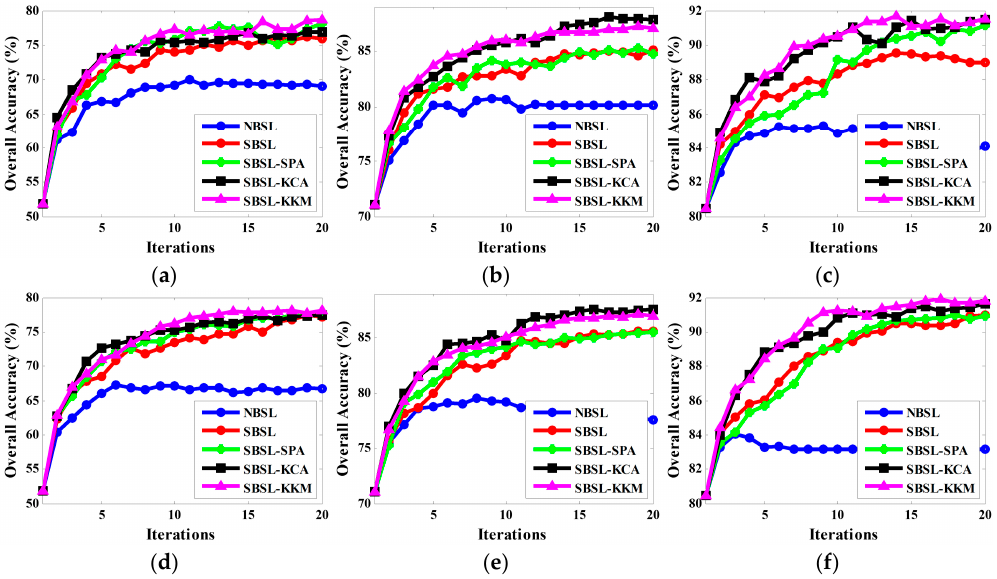
Figure 5. Overall accuracies (as a function of AL iteration) obtained for the data set of the Indian Pines region. ( a ) 5 labeled samples, MBT; ( b ) 10 labeled samples, MBT; ( c ) 15 labeled samples, MBT; ( d ) 5 labeled samples, MMS; ( e ) 10 labeled samples, MMS; ( f ) 15 labeled samples, MMS. The three figures in each line show the OAs using different amounts of training samples, i.e., 5 labeled samples per class with 27 selected samples per iteration, 10 labeled samples per class with 36 selected samples per iteration, 15 labeled samples per class with 45 selected samples per iteration.